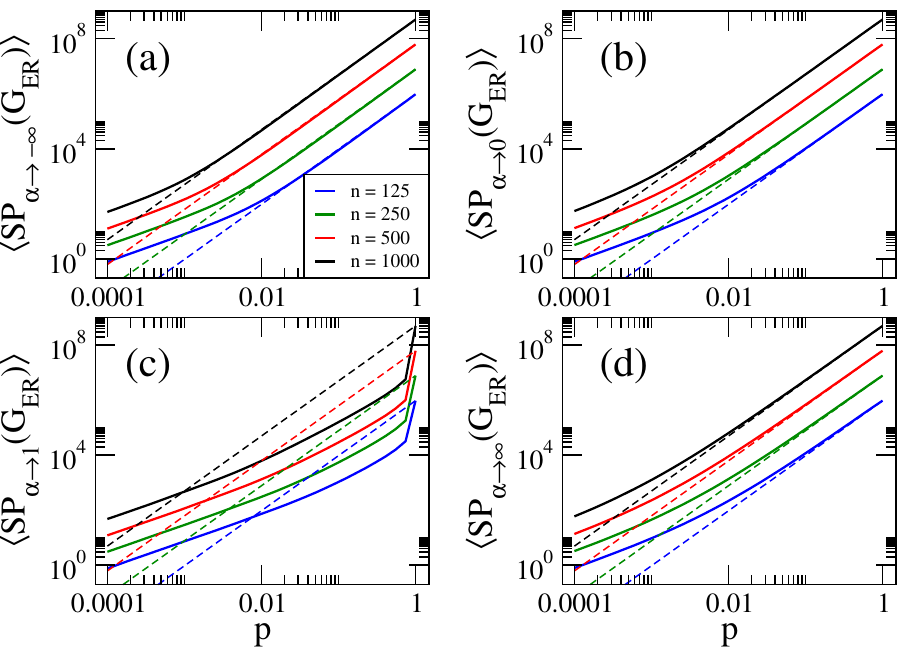
Figure 1: Average value of the Stolarsky–Puebla index (cid:104) SP as a function of the probability p of Erd¨os-R´enyi networks α ( G ER ) (cid:105) of size n . Here (a) α → −∞ , (b) α → 0 , (c) α → 1 , and (d) α → ∞ . Dashed lines correspond to (9). function of the probability p of ER networks of sizes n = { 125 , 250 , 500 , 1000 } . From this figure we observe that the curves of (cid:104) SP are monotonically increasing functions of p α ( G ER ) (cid:105)